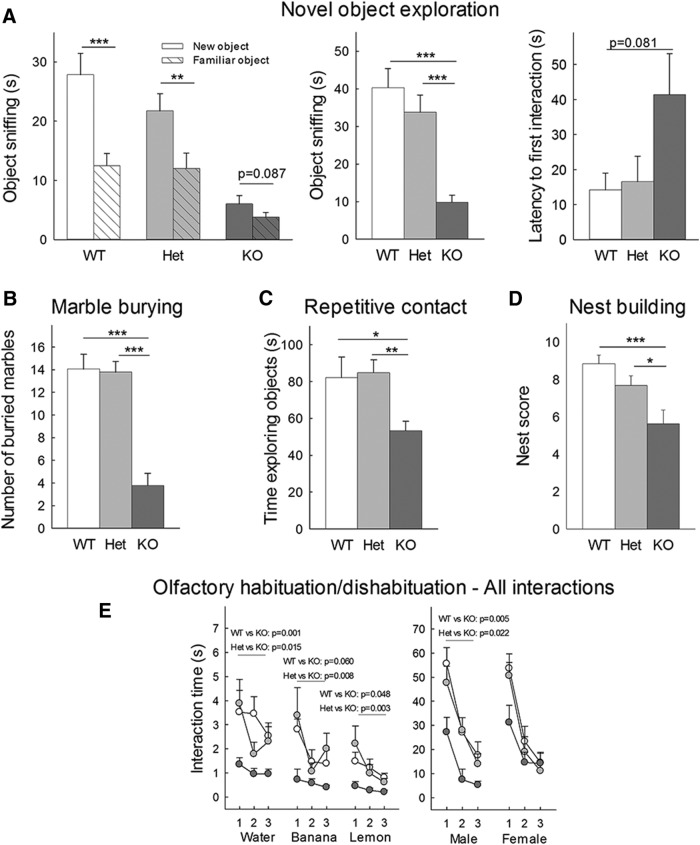
Object avoidance behavior in Shank3Δ4-22-deficient mice. A, Short-term memory measured by the time of interaction with familiar and new object in the novel object recognition test. The test consisted of a training with two identical objects followed 1 h later by a testing session where one of the object was replaced by a novel object. During the testing session, both wild-type and Shank3Δ4-22 heterozygous mice had a strong preference for the novel object over the familiar object, while Shank3Δ4-22 homozygous mice failed to display a preference. However, this failure was due to an avoidance of both objects as shown by the strong decrease in object interaction and the increase in latency to explore any of the object for the first time in Shank3Δ4-22 homozygous animals, rather than to a real lack of object preference. Representative heatmaps for the three genotypes are available in Extended Data Figure 6-1A. B, Repetitive behavior and object avoidance measured in the marble burying test by the number of marble buried during a 30-min session. Shank3Δ4-22homozygous mice displayed a strongly impaired burying behavior, leaving most of the marbles undisturbed. Representative pictures and individual data are displayed in Extended Data Figure 6-1B. C, Time spend exploring objects in the repetitive novel object contact task. Shank3Δ4-22 homozygous mice spent significantly less time interacting with the objects than their wild-type and heterozygous littermates. D, Nest building scores. Shank3Δ4-22 homozygous mice are building less elaborate nests and use less nesting material than their wild-type and heterozygous littermates. Representative pictures of the nests and individual data are displayed in Extended Data Figure 6-1C. E, Time interacting with the scent applicator (touching, biting, climbing) during the olfactory habituation/dishabituation test. Shank3Δ4-22 homozygous mice are avoiding interaction with the scent applicator for all nonsocial scents and for a social male scent but have interaction level similar to wild-type and heterozygous animals when presented with a female scent. WT, wild-type mice; Het, heterozygous mice; KO, homozygous knock-out mice. *p < 0.05, **p < 0.1, ***p < 0.001.